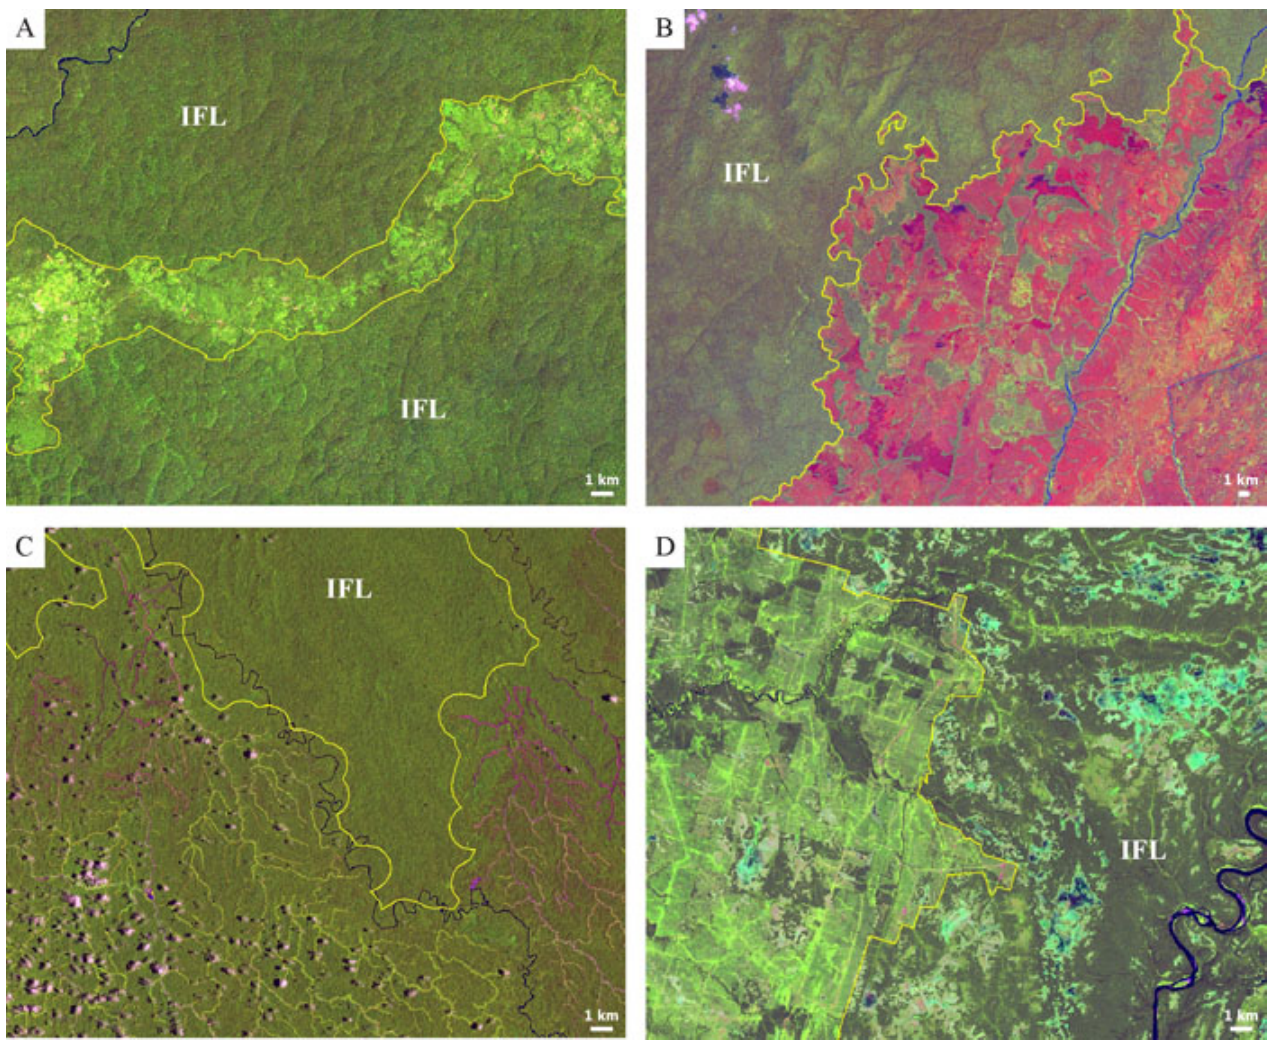
Fig. 1. Examples of IFL boundaries (yellow line) mapped on Landsat ETM+ images (band combination used is 5-4-3). (A) Democratic Republic of the Congo. Settlements, agricultural areas, and buffered area along the road have been excluded. (B) Democratic Republic of the Congo. Savanna grazing areas affected by annual human-induced fires have been excluded. (C) Papua–New Guinea. Logging concession areas have been excluded. (D) Northern European Russia. Clearcuts have been